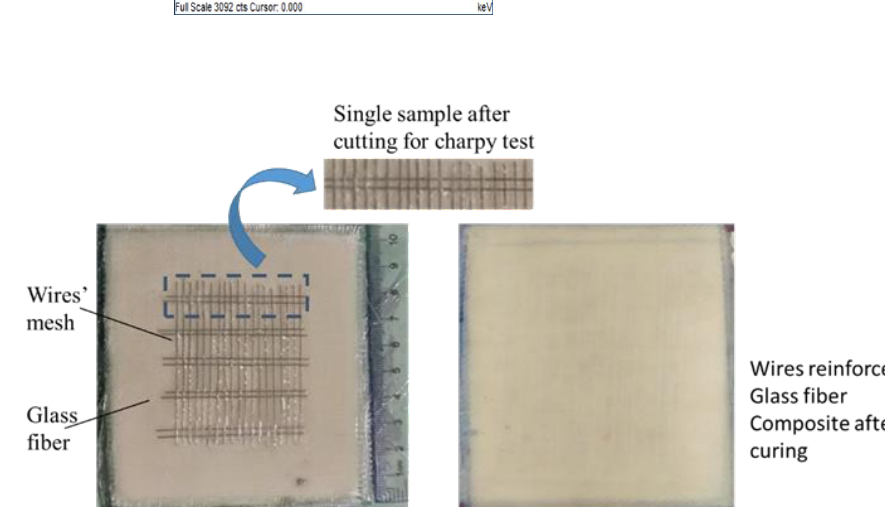
Figure 4. Glass fiber with wires ’ mesh.